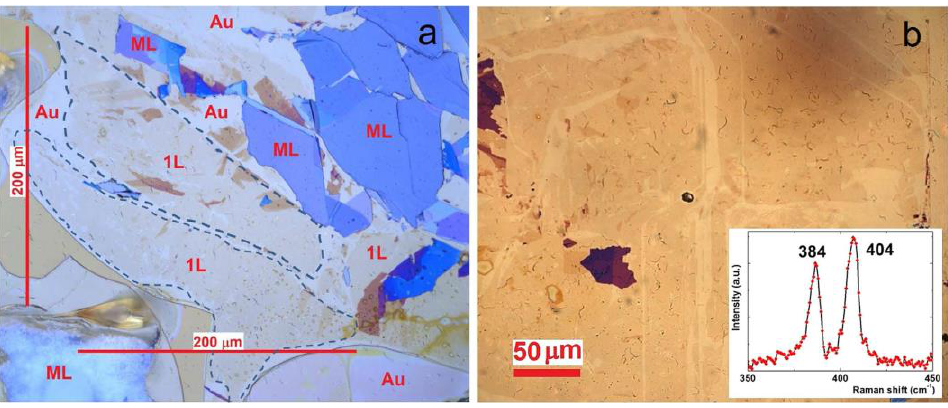
Figure 2. Large area MoS 2 flakes exfoliated with chemically enhanced adhesion to the substrate